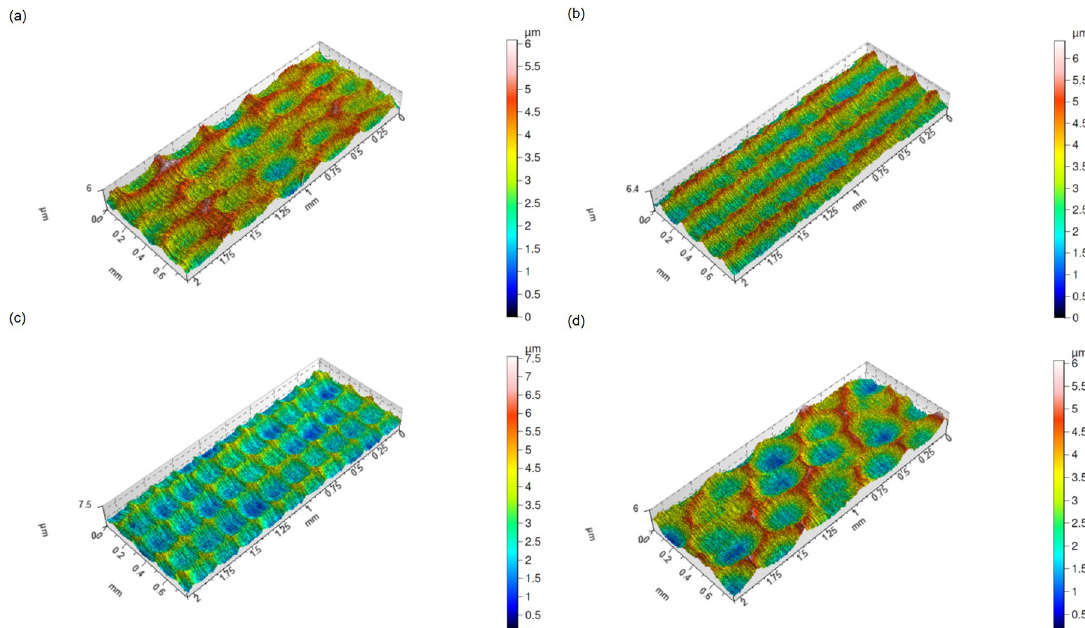
Figure 2. Surface topographies generated by vertical tool path orientations at inclined workpiece angle of 15º (a) VUD, (b) VUU, (c) VDD, (d)